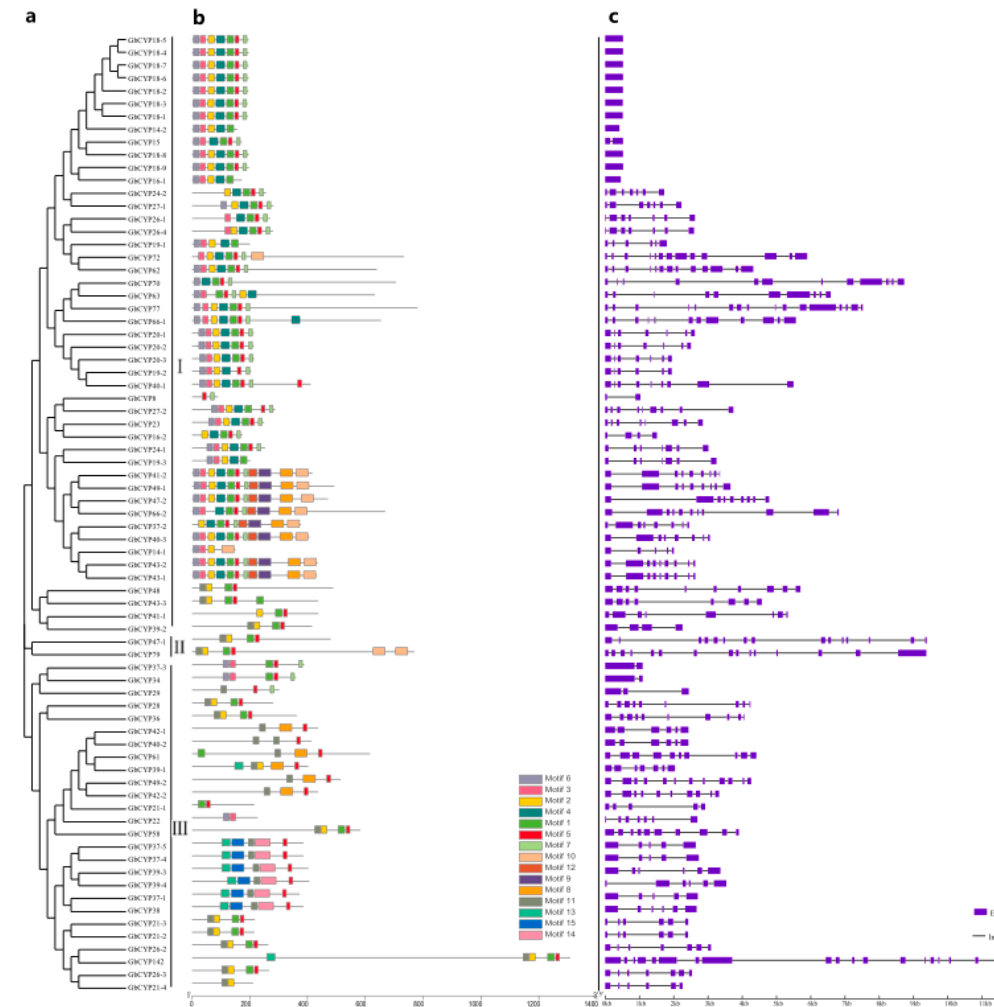
Figure 2. ( a ) Phylogenetic relationship, ( b ) motif analysis and ( c ) exon ‐ intron gene structures of the CYP gene family in G. barbadense . a phylogenetic analysis of GbCYPs using the NJ method. b Motifs 1, 2, 3, 4, 5, 6 and 7 together compose the cyclophilin ‐ like domain (CLD). Motif 8 is a TPR (tetratricopeptide repeat) domain function. c Structures of CYP genes.